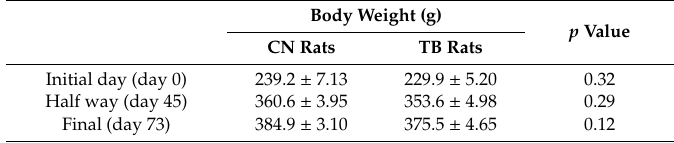
Table 1. Body weights for control rats (CN rats) and theobromine-fed rats (TB rats) in experiment